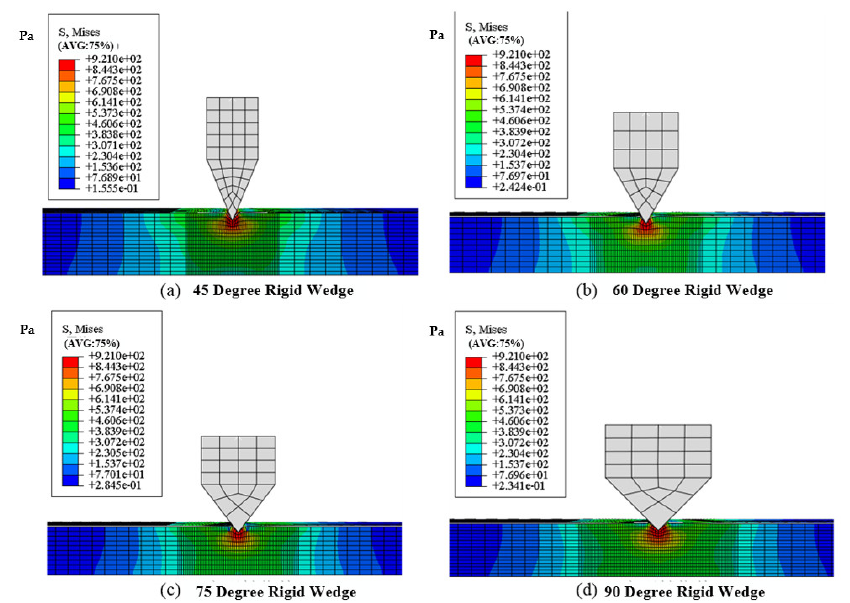
Figure 12. Stress Distribution of Specimens Embedded with Rigid Wedges of 45 º , 60 º , 75 º and 90 º .